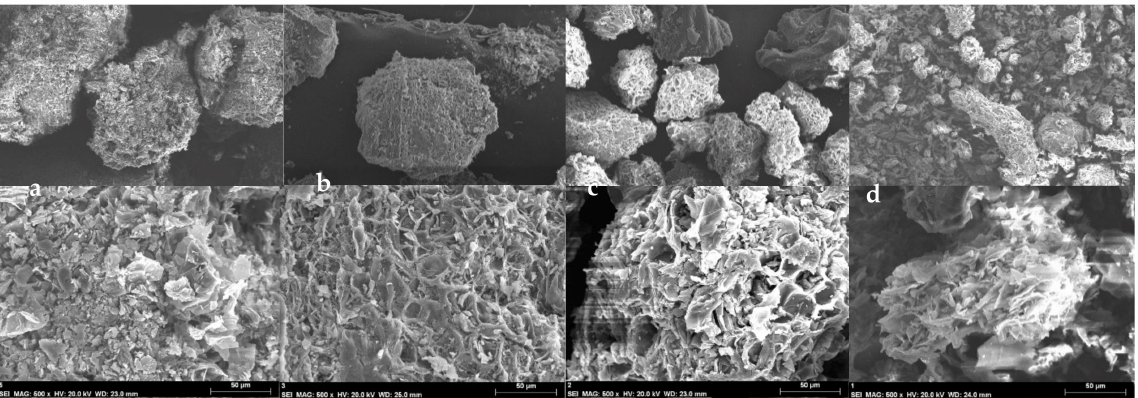
Figure 3. Typical morphology of the particle sizes in samples from pecan pericarp residues. ( a )—Sieve